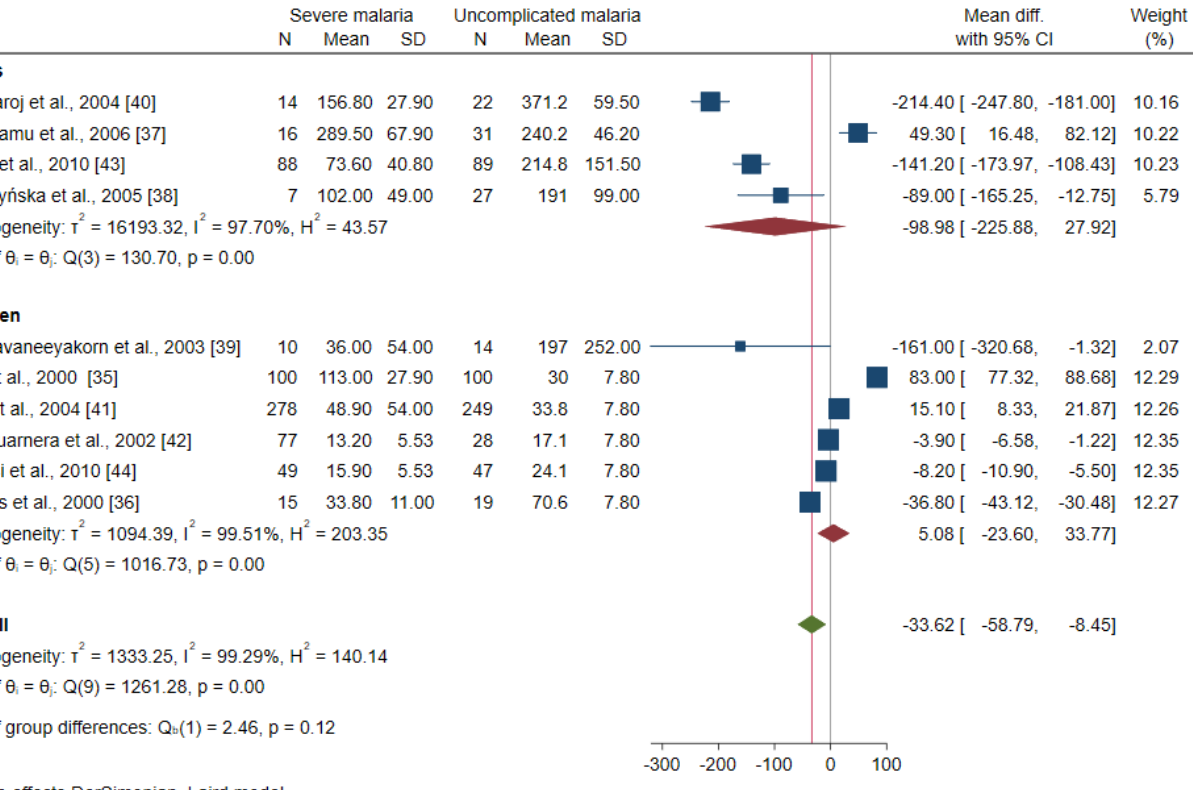
Figure 4. Forrest plot demonstrated the difference in the mean IL-12 levels (pg/mL) between patients with severe malaria and uncomplicated malaria stratified by age groups [35–43]. Abbreviation: Mean Diff., mean difference; CI, confidence interval. Explanation of the forest plot: squared-box symbol, point estimate; green diamond and red line: pooled mean difference: red diamond: pooled mean difference in each subgroup; blue line: line of no effect; I 2 , level of heterogeneity; p = 0.00 or less than 0.05, significant heterogeneity.